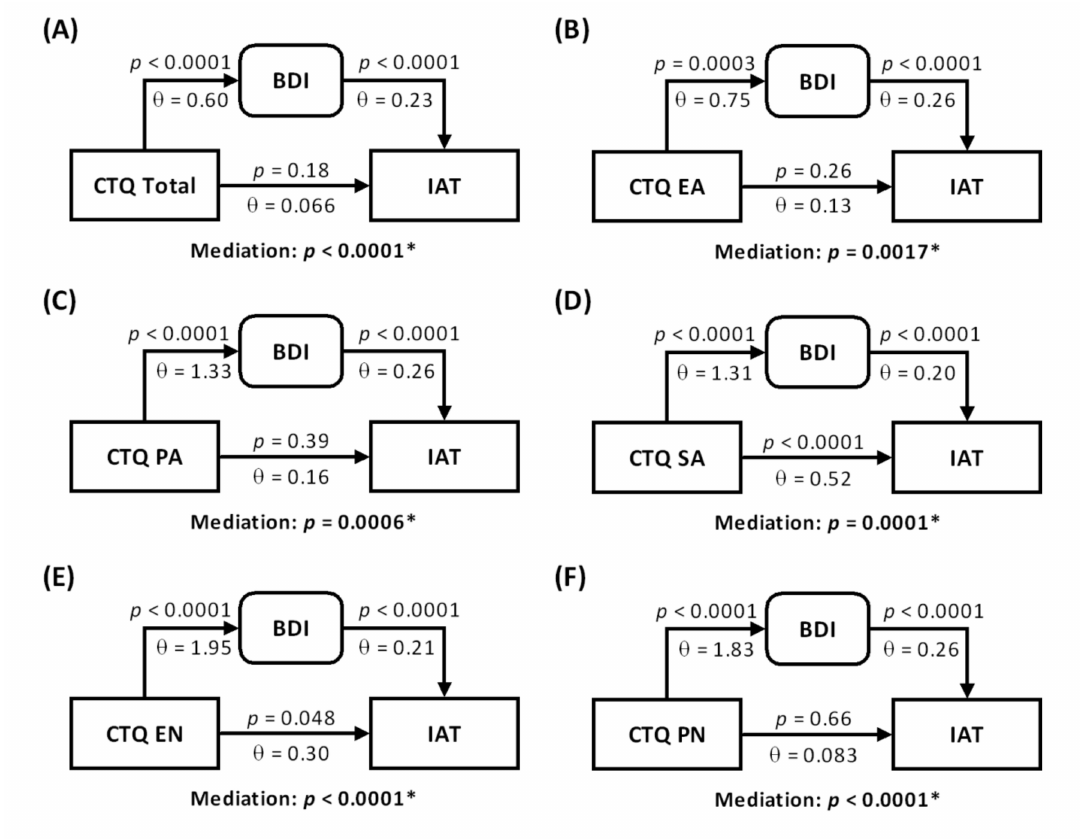
Figure 4. Mediation analysis of the BDI, IAT and CTQ totals ( A ) and subscores ( B – F ) in internet-addicted females. The p -values associated with mediation are for the path “a × b” (see Section 2.4). All models are significant, suggesting that the BDI mediated the relationship between the CTQ total/subscores and the IAT score. Specifically, the relationships of the CTQ total and the EA, PA and PN scores with the IAT were completely mediated by the BDI